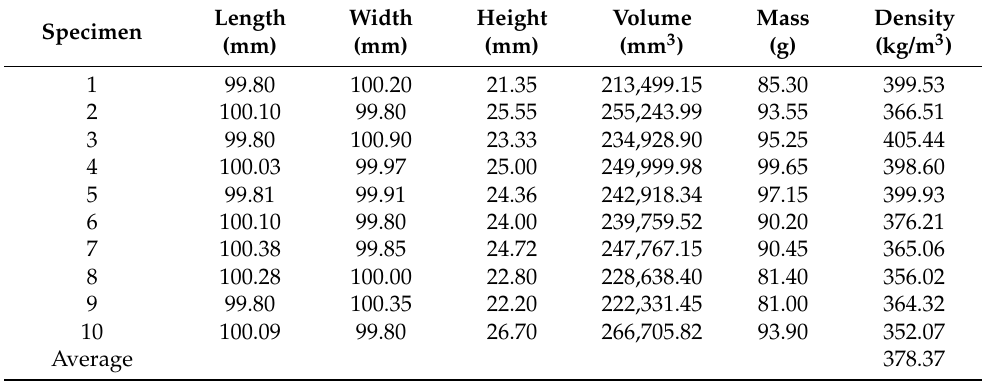
Table 1. Density of timber.